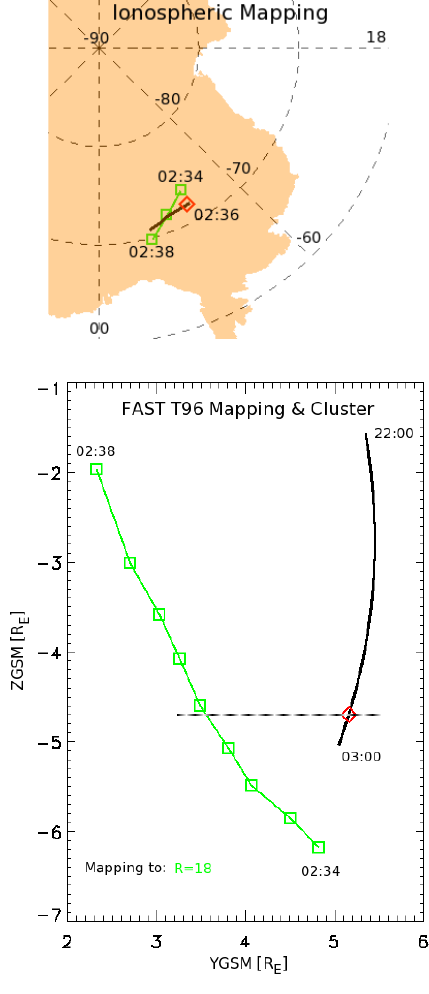
Fig. 4. Top: Ionospheric projections of Cluster 1 and FAST in ec- centric dipole coordinates. Midnight is at the bottom and dusk to the right (Southern Hemisphere). The FAST footprint is shown 4min around CJ3 time, while for Cluster 1 we have the same 5-h inter- val as in Fig. 3. Bottom: Tail projections of FAST and Cluster 1 in (Y GSM ,Z GSM ) coordinates. The FAST position is mapped to 18 R E , about equal to the geocentric distance of Cluster around the conjunction time. In both plots FAST is indicated with green squares while the Cluster 1 trace is shown in black and a red dia- mond is overplotted at the conjunction